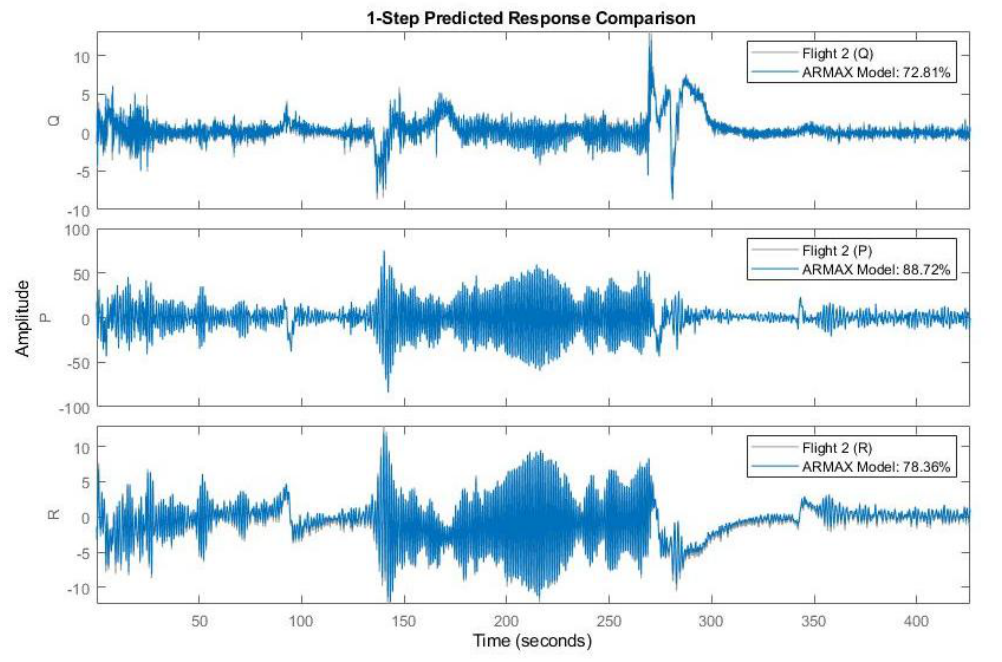
Figure 23. Validation of ARMAX Model with Second Flight